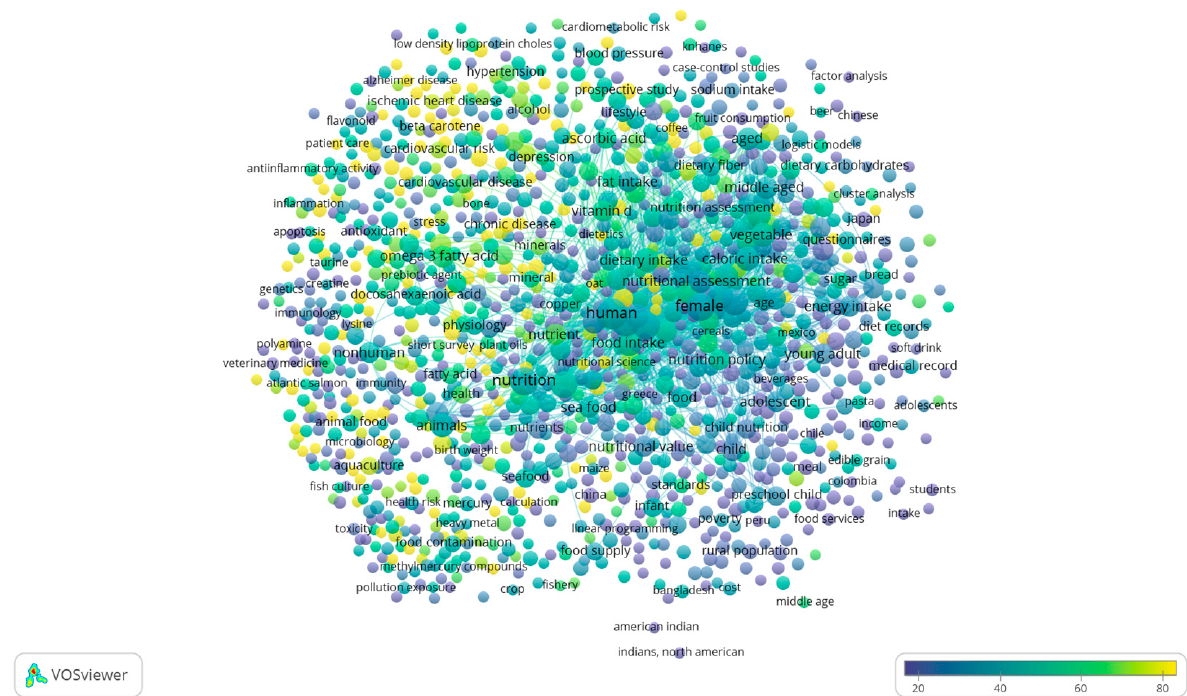
Figure 7. Term map of the seafood/fish/nutrients/bioactive compounds relationship, shown as a bubble map visualizing words from titles, abstracts, and keywords of the 1227 publications. Bubble size indicates the number of publications. Bubble color represents the citations per publication (CPP). Two bubbles are closer to each other if the terms co-appeared more frequently. (Based on data from Scopus and elaborated by VOS viewer